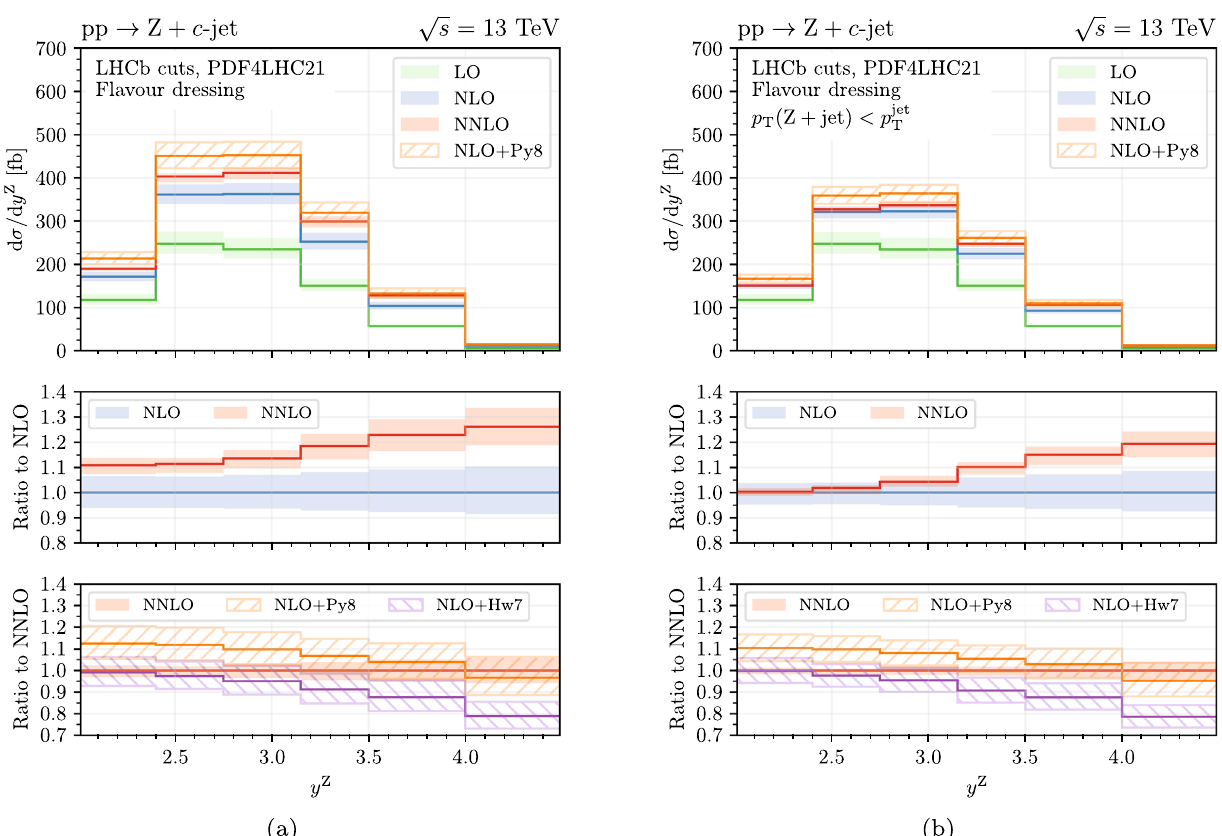
Pythia8 (orange)or Herwig7 (purple)aspartonshowers.Adynamical cut on the transverse momentum of the Z + jet system is further applied in